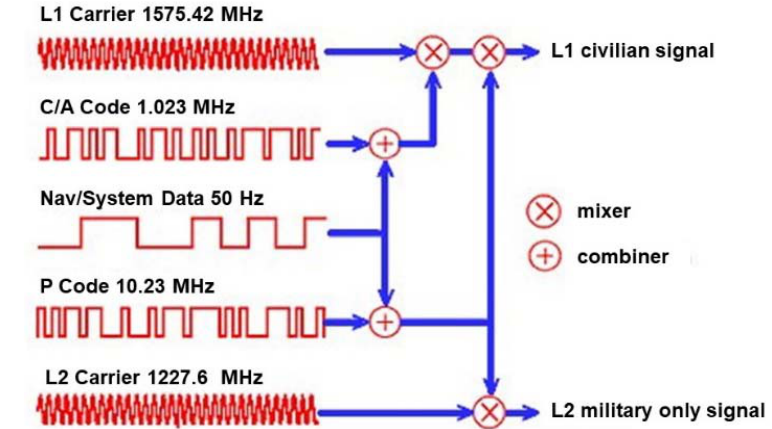
Figure 1  Structure of a GPS signal (Warner & Johnston, 2002,